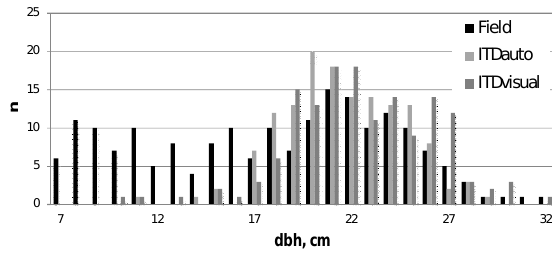
Figure 4. True stem distribution combared to trees detected with ITD auto and ITD visual in young pine forest.